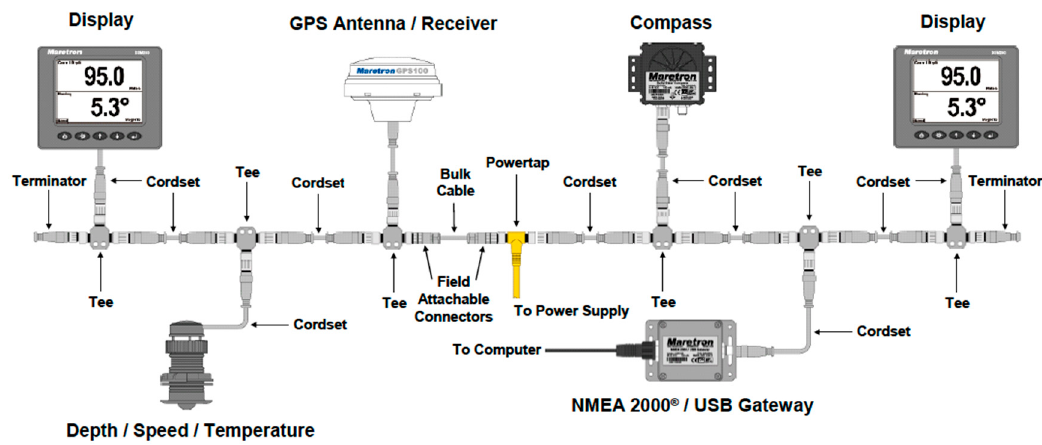
Figure 1. NMEA 2000 network [71].